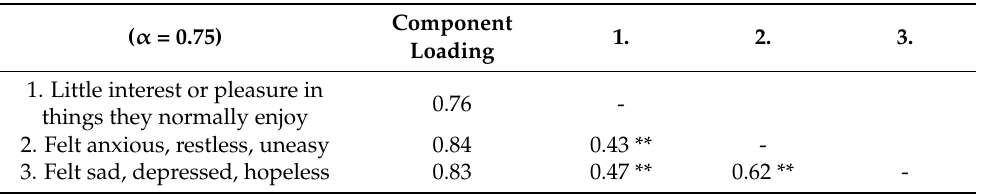
Table A2. Internal consistency, standardized component loadings, and correlations between items on feelings of depression (oblimin rotation).